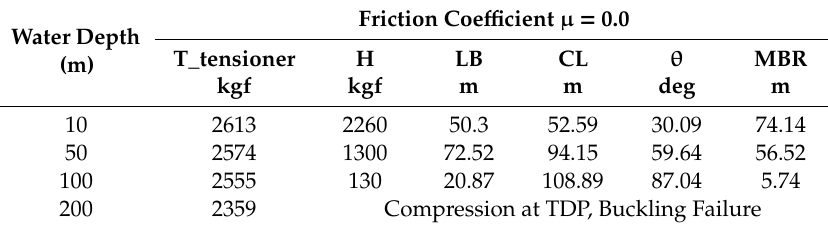
Table 6. Cable critical responses assuming friction coe ffi cient µ =